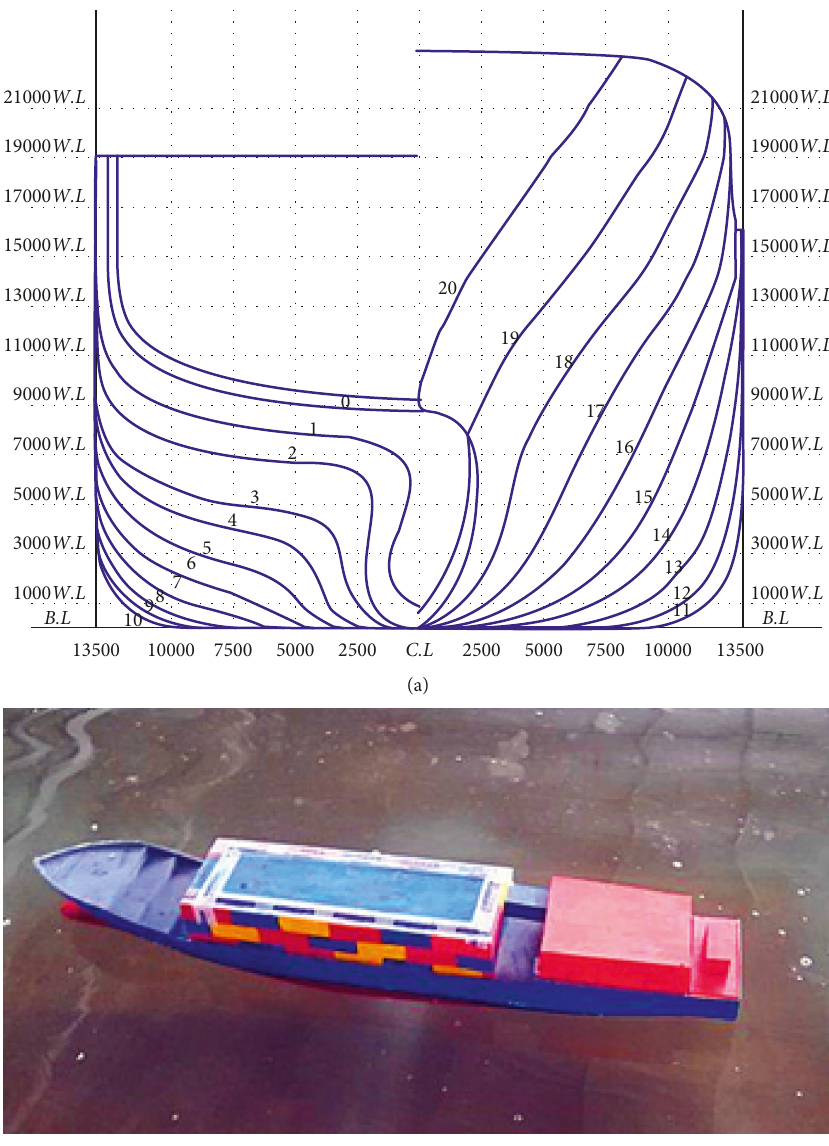
Figure 4: (a) Plan of the ship model; (b) experimental